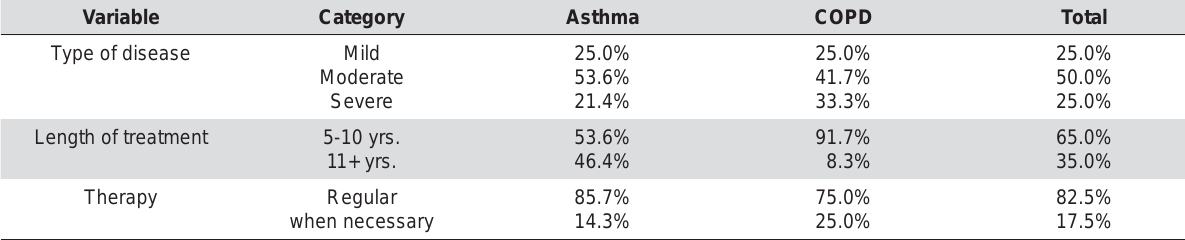
Table 2- Descriptive data about the type of disease, length of treatment, and regularity of therapy Variable